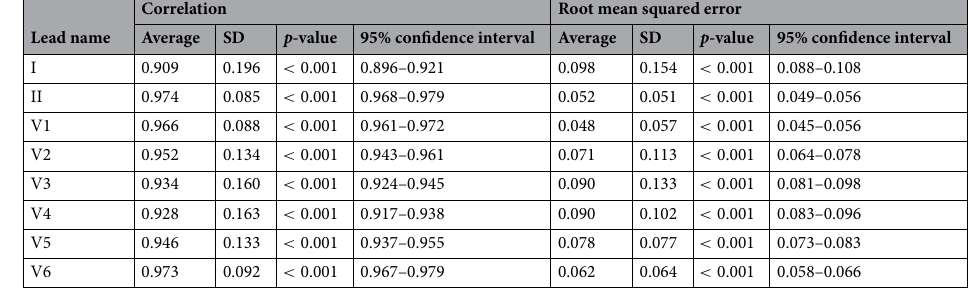
Table 1. Correlation and root mean squared error (RMSE) statistics of the digitised results from 923 standard 3 by 4 ECG images and the ground truth digital ECG before image thresholding (validation 1).